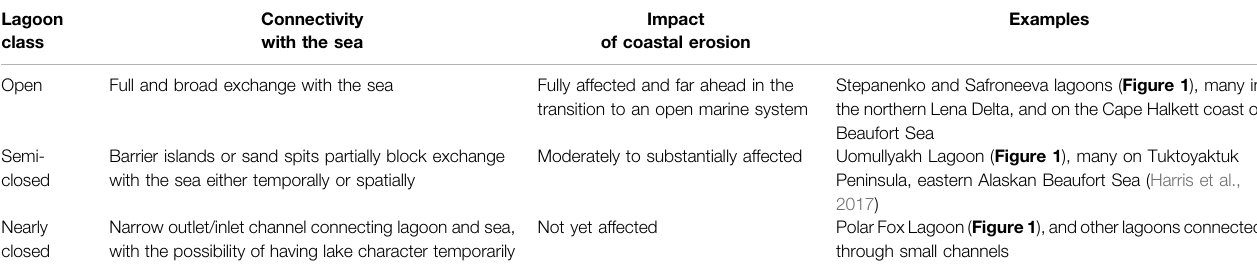
TABLE 1 | Classi fi cation of lagoons into “ open ” , “ semi-closed ” and “ nearly closed ” lagoon systems which occur along a gradient of coastal